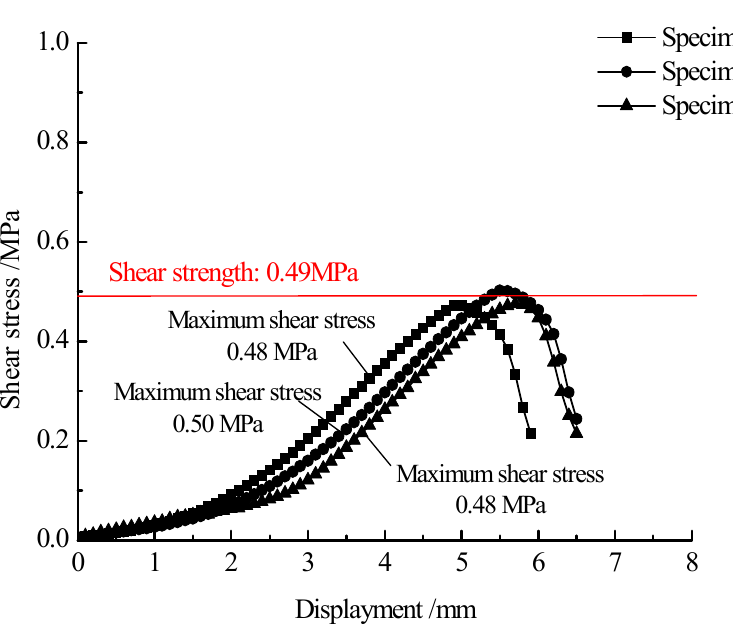
Figure 6. Stress-strain relationship of specimens prepared by the conventional paving method.